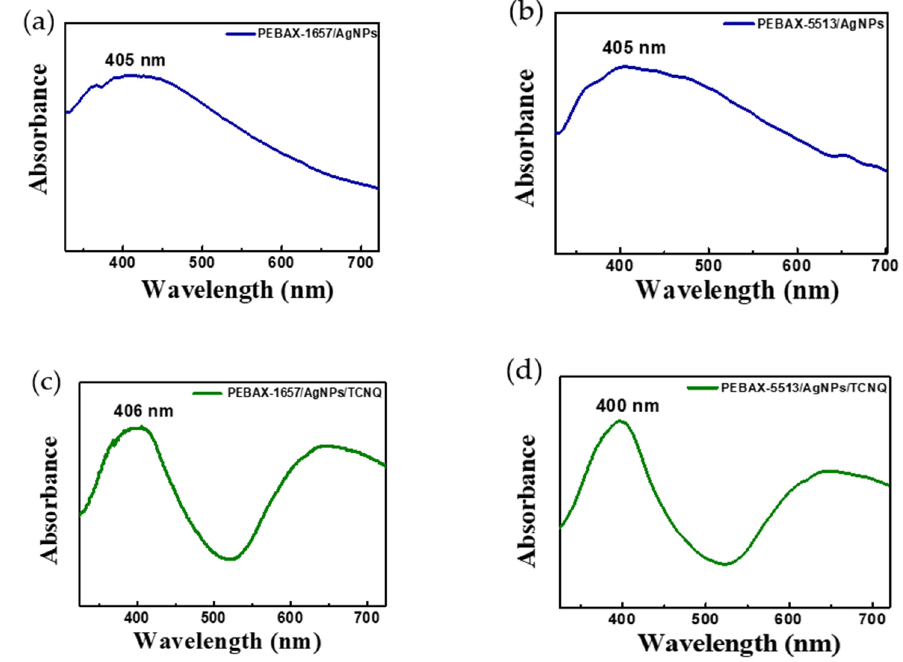
Figure 6. UV-visible absorption spectra of AgNPs in ( a ) PEBAX-1657/AgNPs, ( b ) PEBAX- 5513/AgNPs, ( c ) PEBAX-1657/AgNPs/TCNQ, and ( d ) PEBAX-5513/AgNPs/TCNQ